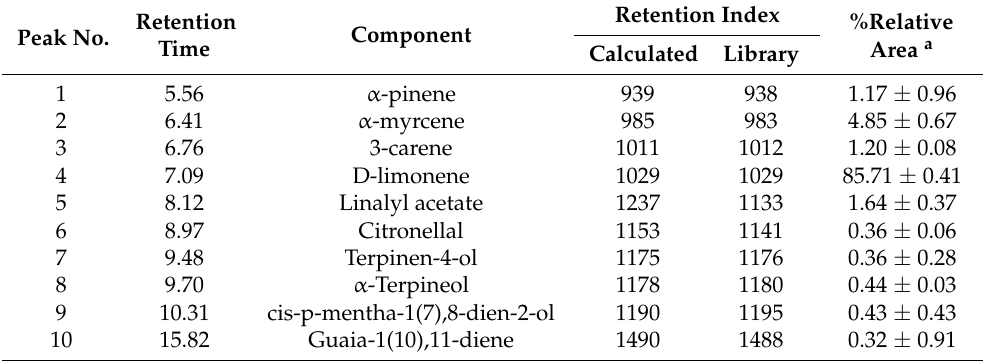
Table 1. Chemical constituents of the peel of the C. limetta essential oil. Peak No.